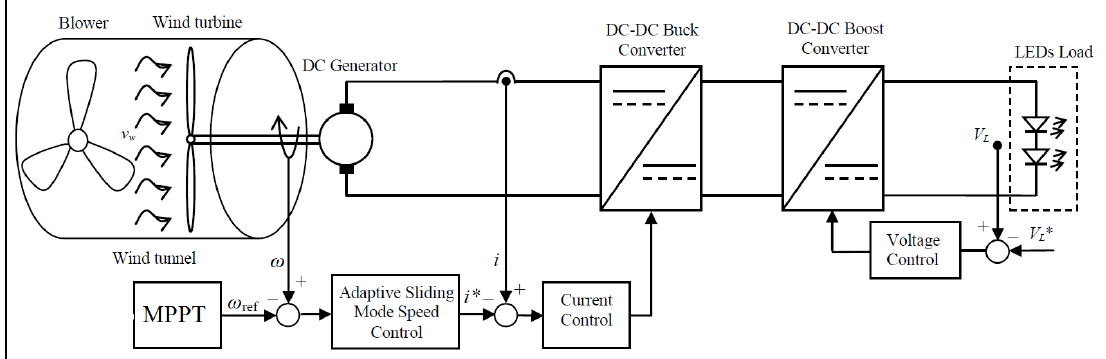
Figure 2. Schematic representation of the adaptive SMC system applied to the wind energy experimental setup.